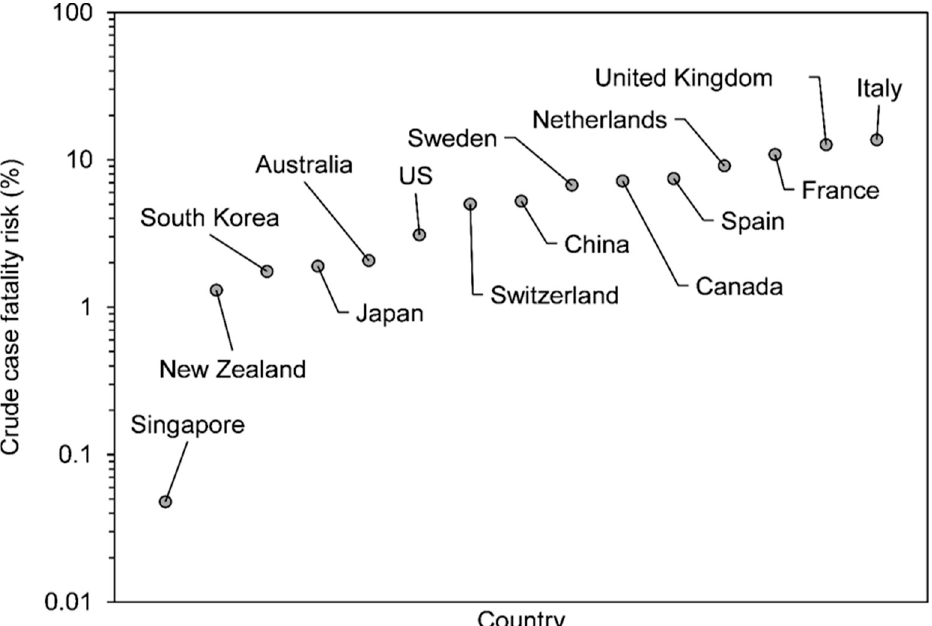
Figure 1. Crude case fatality risk of 2019 novel coronavirus disease (COVID-19) by country. The vertical axis represents the crude CFR value of COVID-19. Countries are ordered from the lowest to highest according to the CFR estimate, mostly sampled from high-income countries with surveillance systems to count the number of confirmed COVID-19 cases.